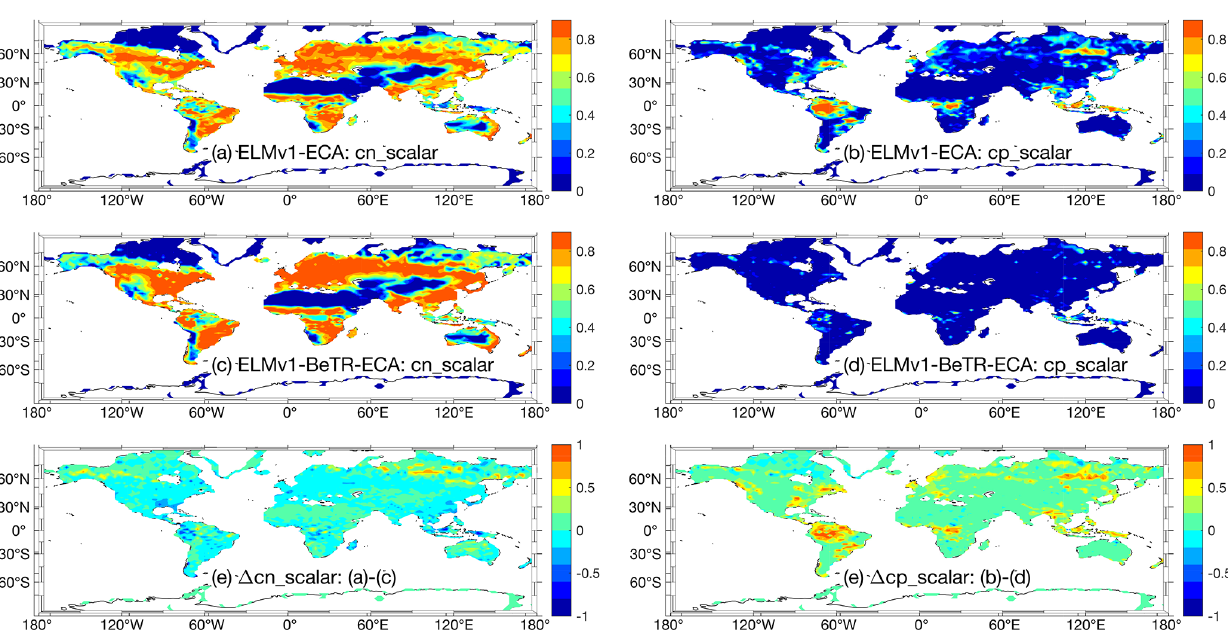
Figure 6. Comparison of simulated plant nutrient stresses (on a scale from zero to one) at year 2010. Panels (a) , (c) , and (e) are for nitrogen stress, and panels (b) , (d) , and (e) are for phosphorus stress. Greater values indicate stronger limitation for the corresponding